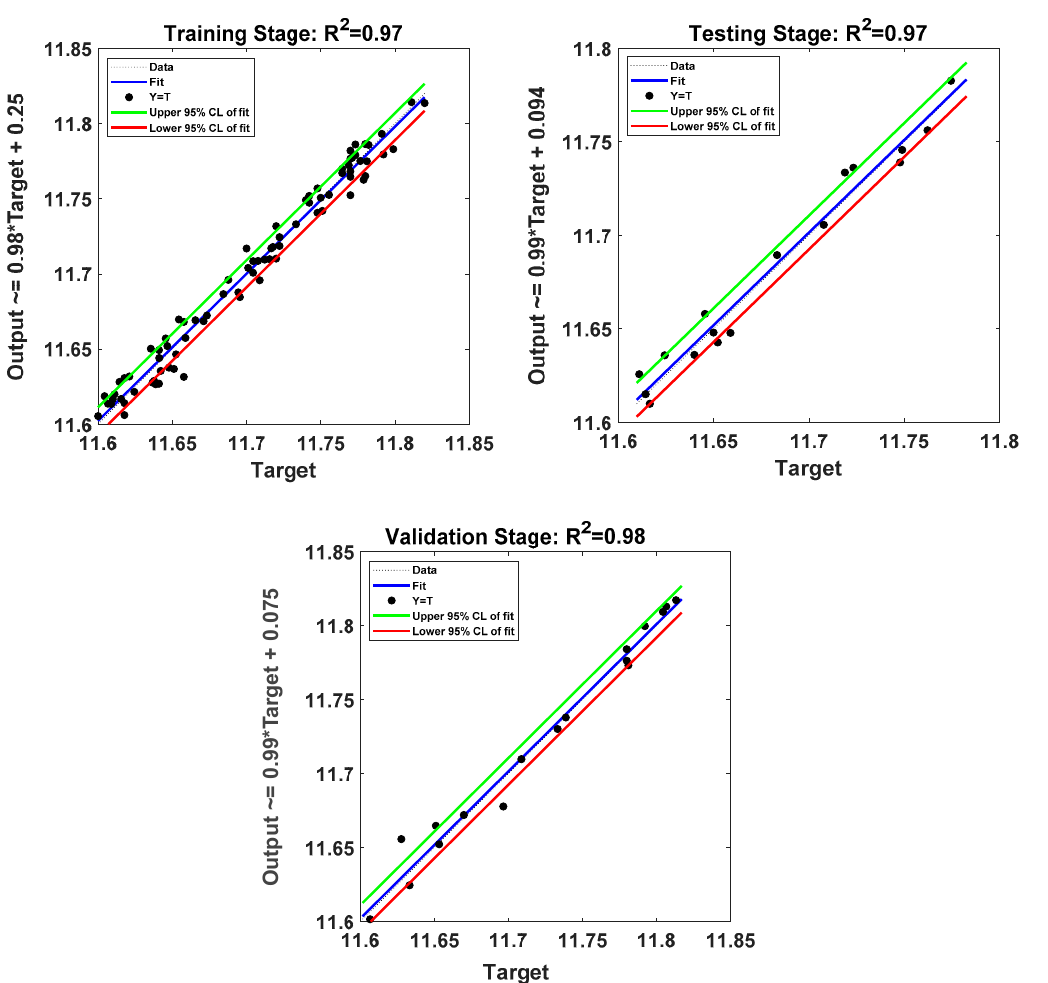
Figure 6. Performance of the combined model in training, testing and validation stages.